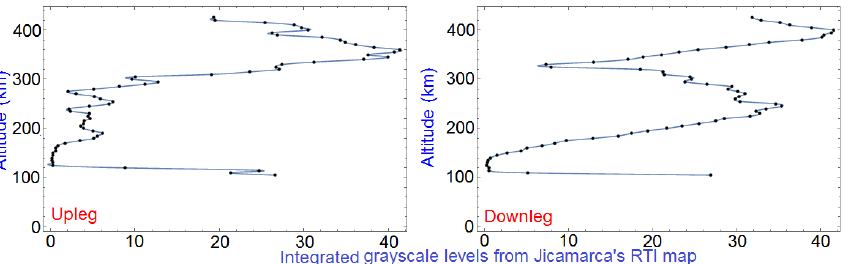
Figure 9. Integrated grayscale levels of the modified RTI map shown in Fig. 8. Irregular structures are represented by higher integrated grayscale levels.